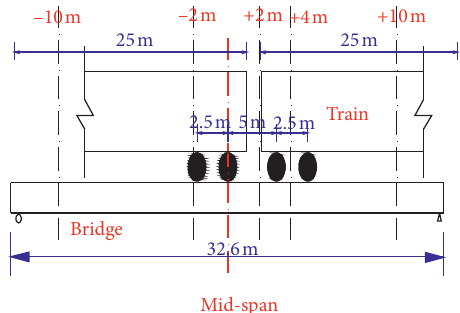
Figure 16: Vibration calculation diagram of different steel arches in the longitudinal direction.